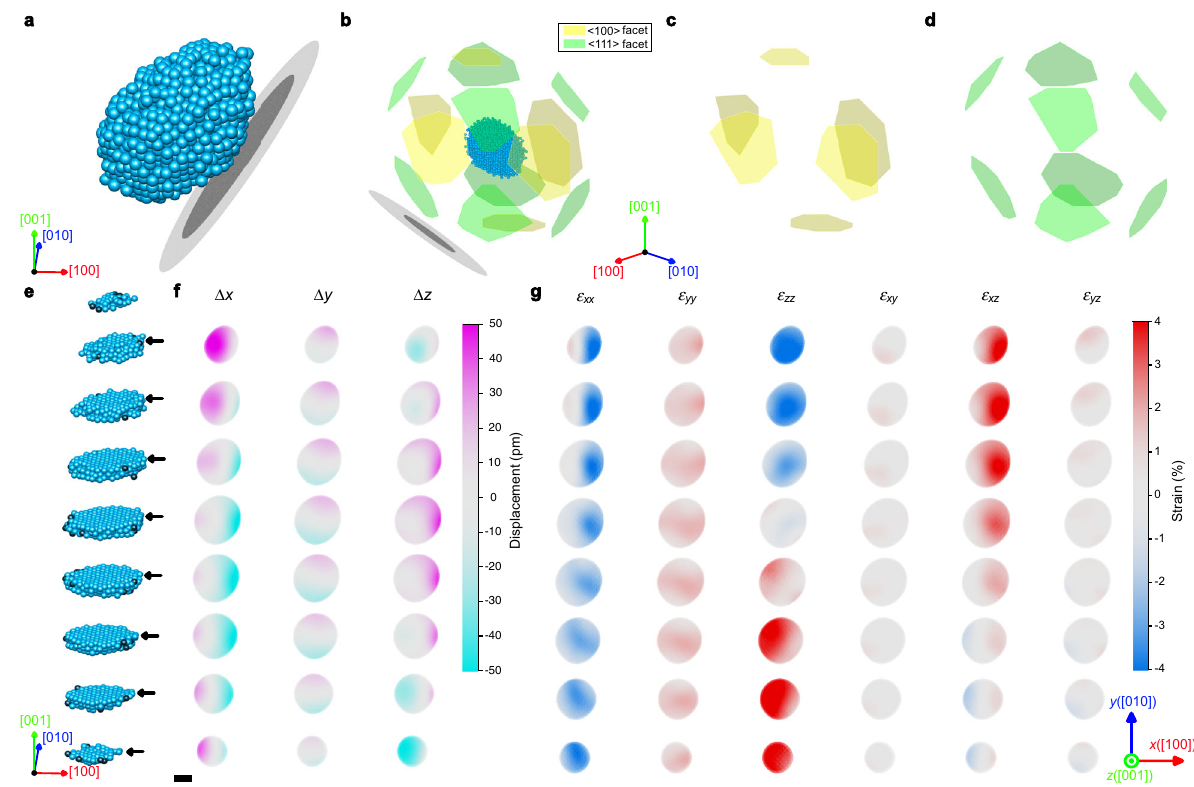
Fig. 4 Facets, 3D atomic displacements, and strain maps of the Pt nanoparticle. a Overall atomic structure of the Pt nanoparticle with SiN substrate represented as black and gray disks. b – d Identi fi ed facet structure of the Pt nanoparticle, showing all facets ( b ), <100> facets ( c ), and <111> facets ( d ). e Atomic structure of the Pt nanoparticle represented in a divided into layers of one f.c.c. unit cell thickness. Blue and black atoms represent the atoms assigned and not-assigned to the ideal f.c.c. lattice sites, respectively. f The atomic displacements along the crystallographic axes. g The strain maps representing six components ( ε xx , ε yy , ε zz , ε xy , ε xz , ε yz ) of the strain tensor. The atomic displacements and strain tensors in each row were calculated from the corresponding slice pointed by the black arrows in e . These calculations were based on the traced atomic model from the tomogram after applying the DL augmentation trained by f.c.c.-based atomic models with Bfactor 5 Å 2 . Scale bar, 2